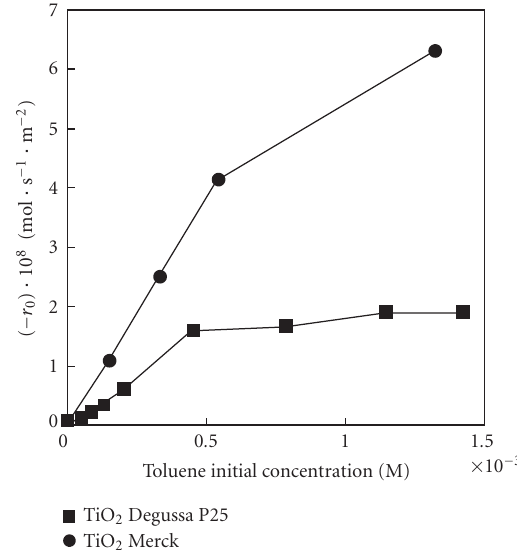
Figure 6: Initial reaction rate of toluene disappearance per unit sur- face area ( − r 0 ) versus initial toluene concentration. TiO 2 Merck ( ); TiO 2 Degussa P25 ( (cid:2)